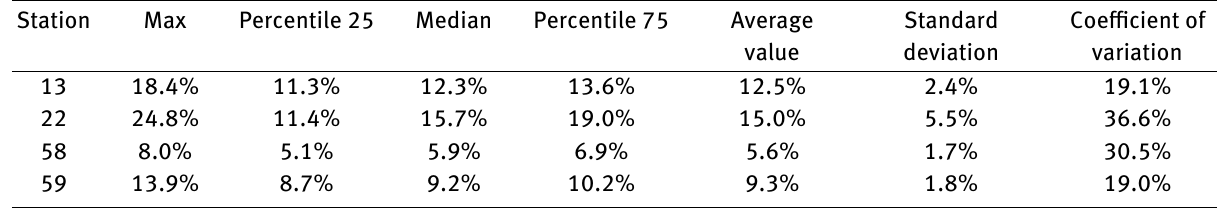
Table 4: Descriptive statistics concerning the daily shares in traflc of overloaded category 9 vehicles due to their gross weight